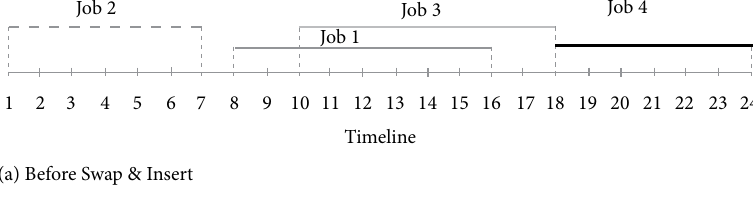
(a) Before Swap & Insert